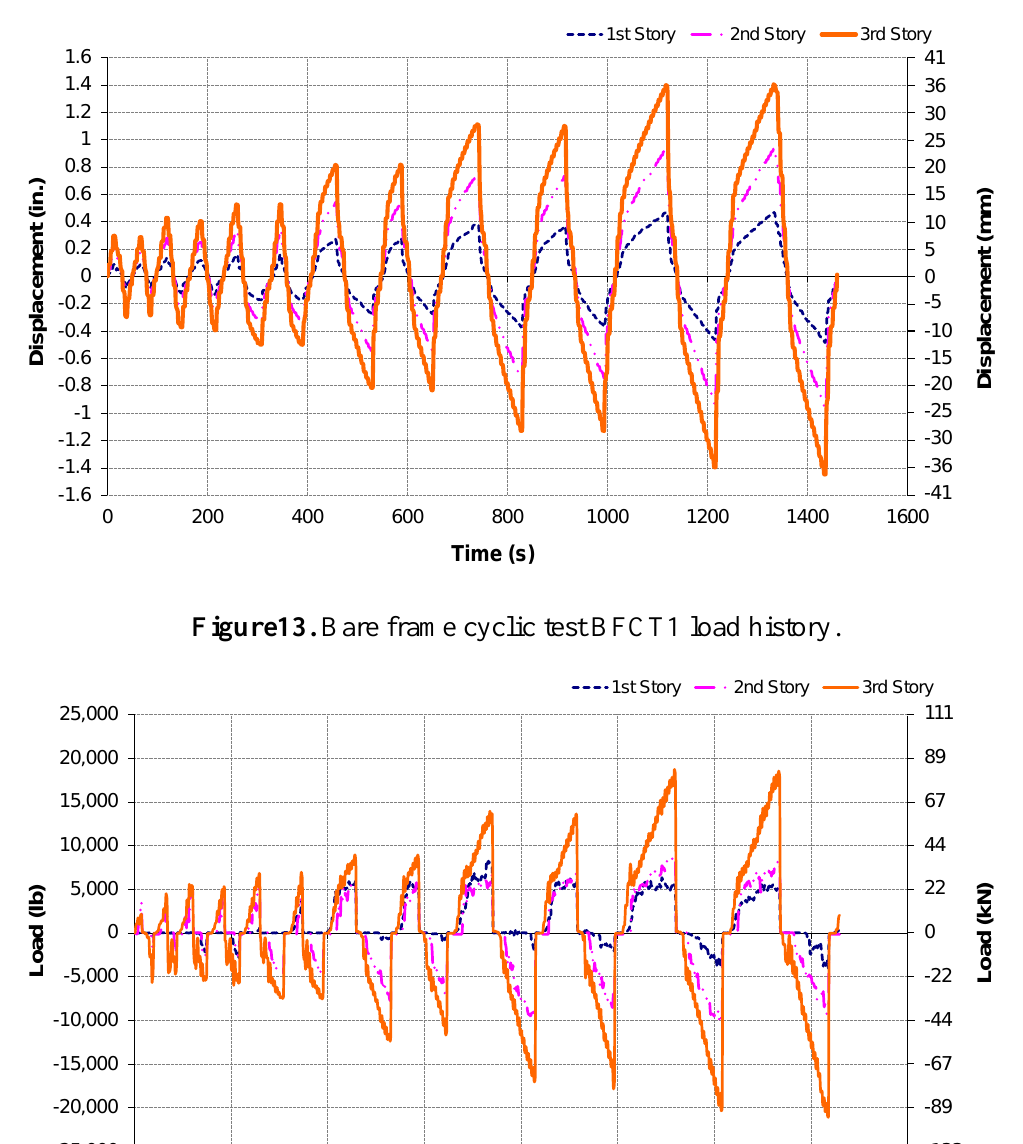
Figure 12. Bare frame cyclic test BFCT1 displacement history.